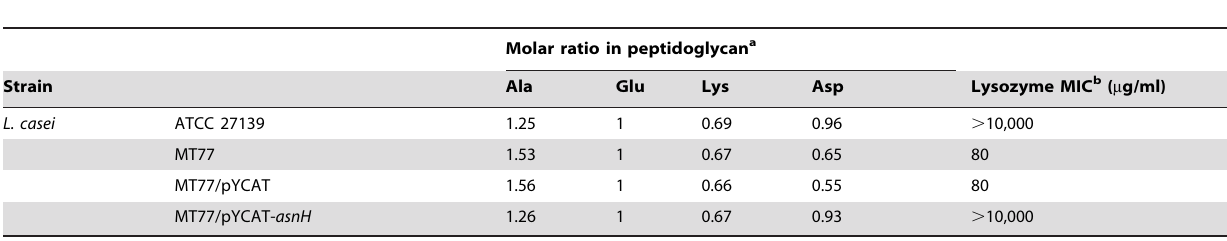
Table 2. Amino acid compositions in peptidoglycans and lysozyme MICs of J1 phage-resistant mutants.